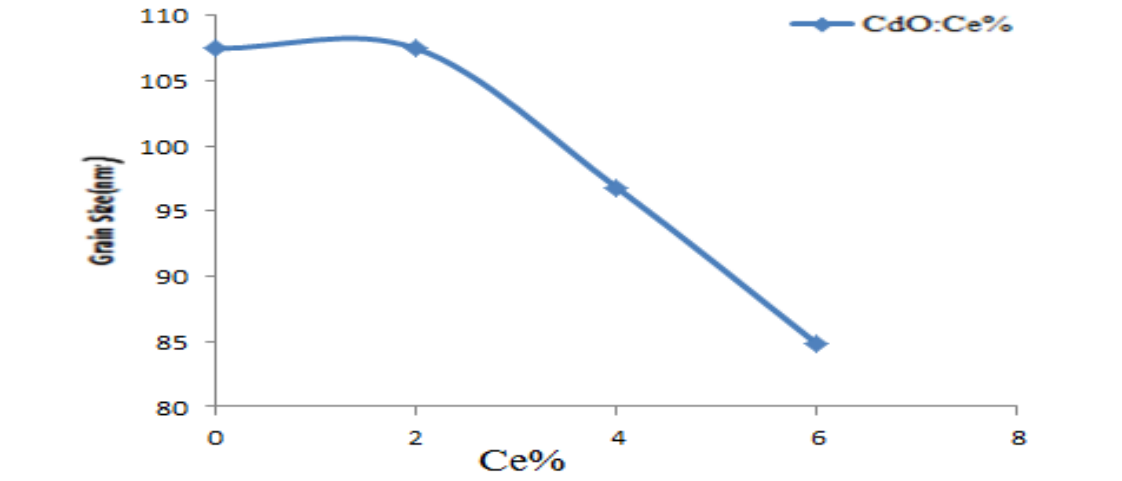
Fig. 8: Variation of grain size with Ce concentration for CdO prepared silicon substrates.